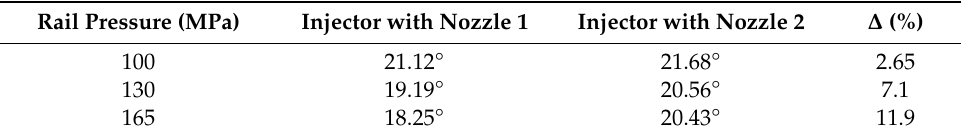
Table 6. Average values of fuel spray cone